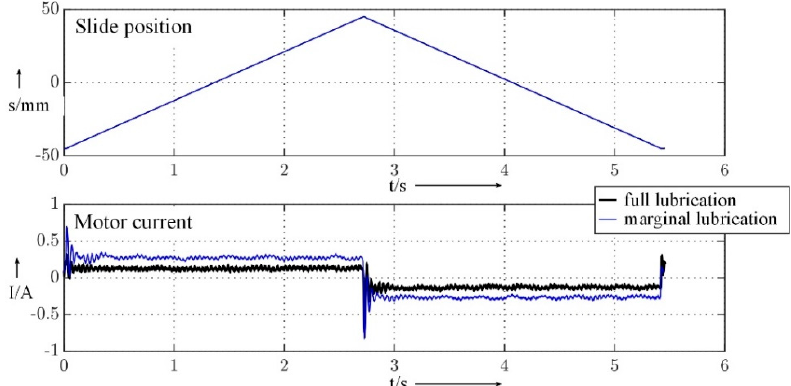
Figure 11. Section of recorded data in idle mode for full lubrication and marginal lubrication. Position of the slide ( top ) and motor current ( bottom ).